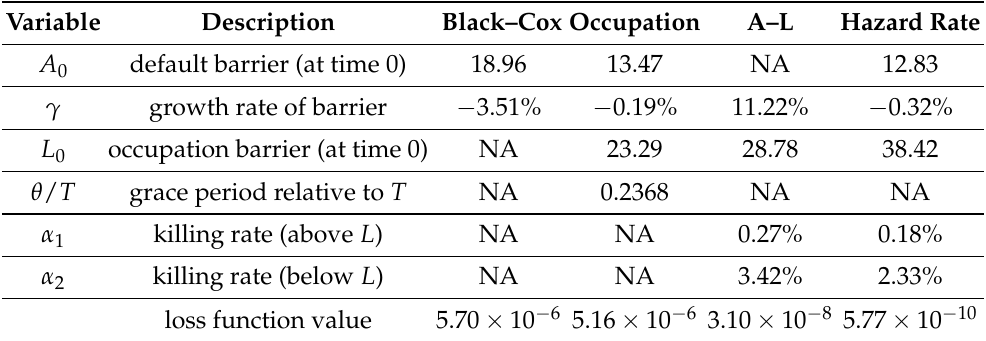
Table 3. Calibration Results for model parameters (the underlying process is GBM). NA means not